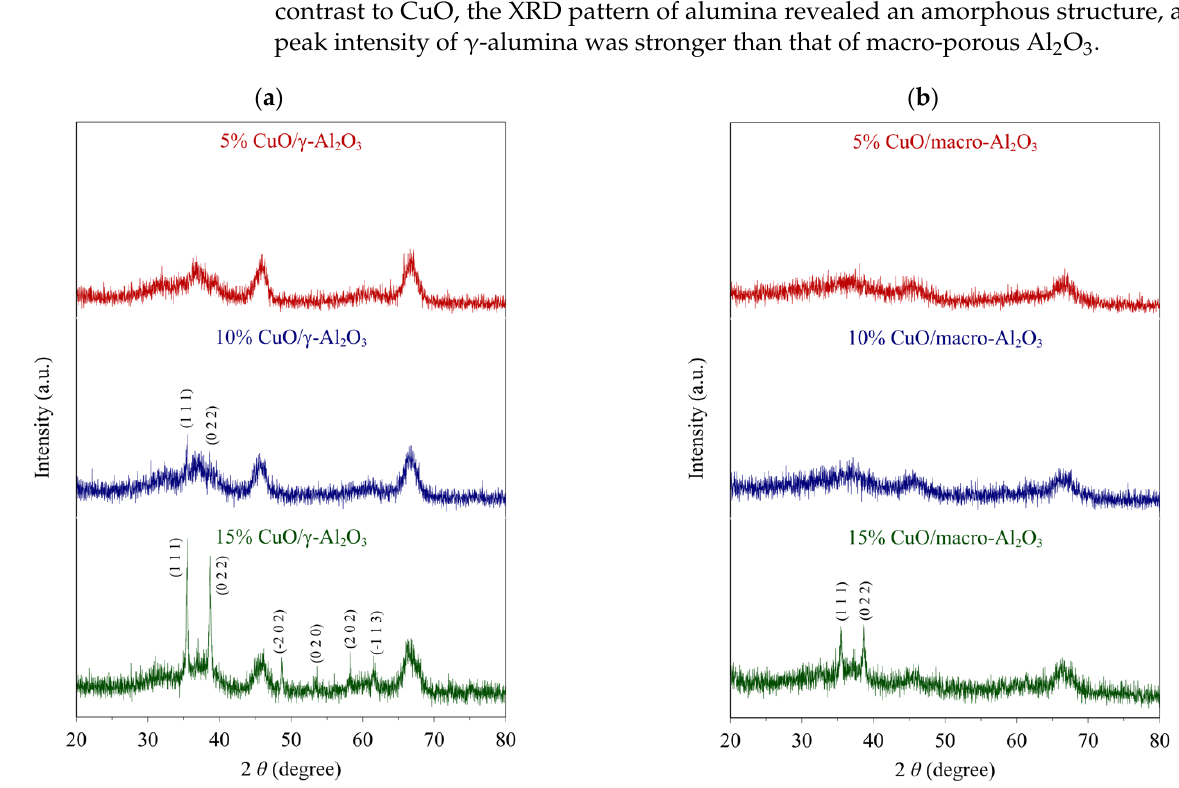
Figure 6. XRD patterns of Cu-based desulfurization sorbents: ( a ) 5, 10, 15 wt % CuO/ γ -Al 2 O 3 ; ( b ) 5, 10, 15 wt % CuO/macro-porous Al 2 O 3 .